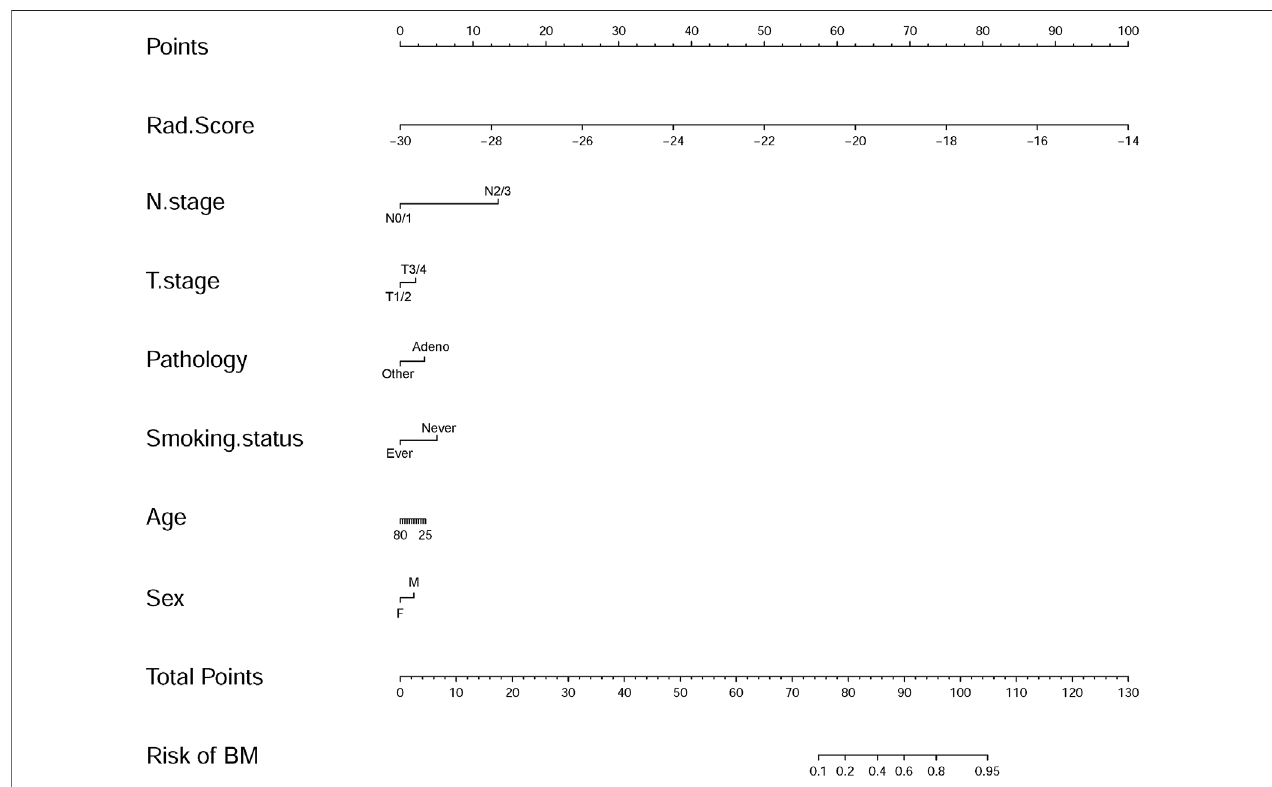
FIGURE 4 | Nomogram developed with the radiomics score (Rad_score) and clinical features incorporated.